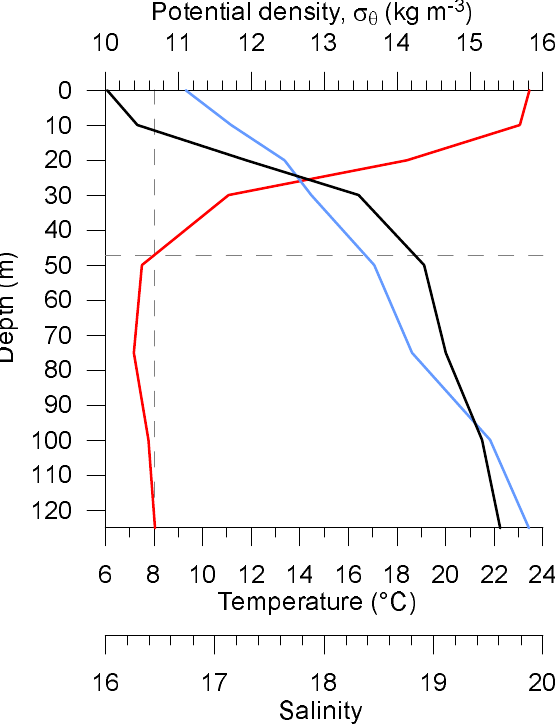
Fig. 2. A typical climatic profile of temperature (red), salinity (blue) and potential density (black) at the outer shelf (44.50 ◦ N, 31.00 ◦ E) in August. The separation between the homogenous layer of Bot- tom Shelf Waters (BSW) and the upper thermocline occurs at ap- proximately 47m (8 ◦ C isotherm), which coincides with the density level of σ θ = 14 . 25kgm − 3